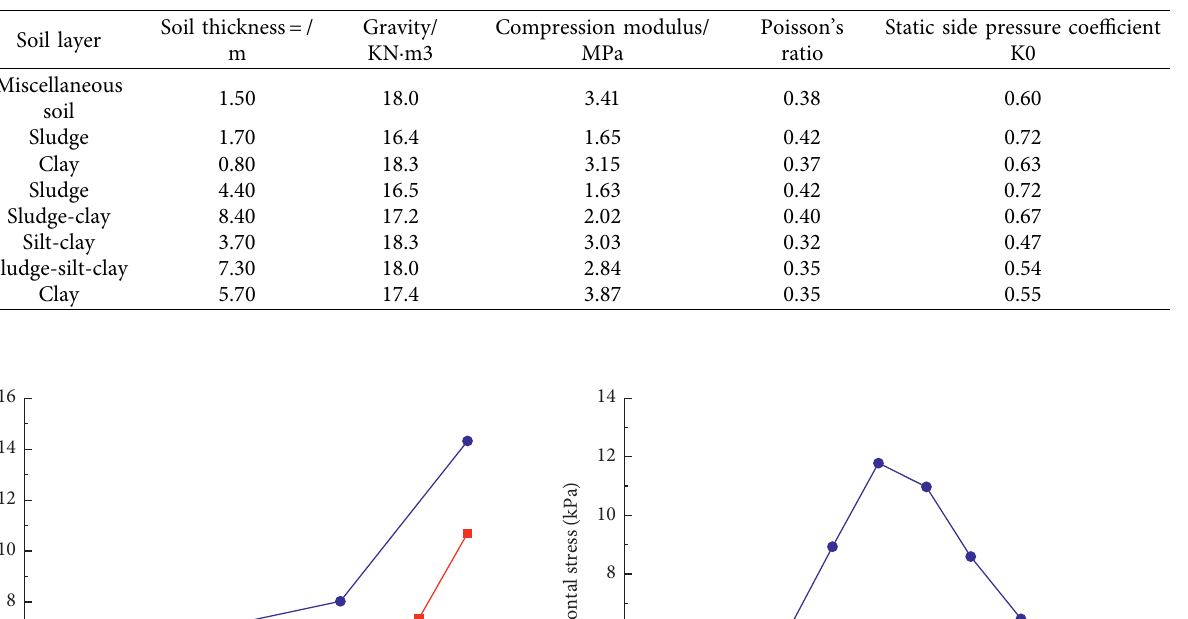
Table 2: Main physical and mechanical properties of the soil layer.